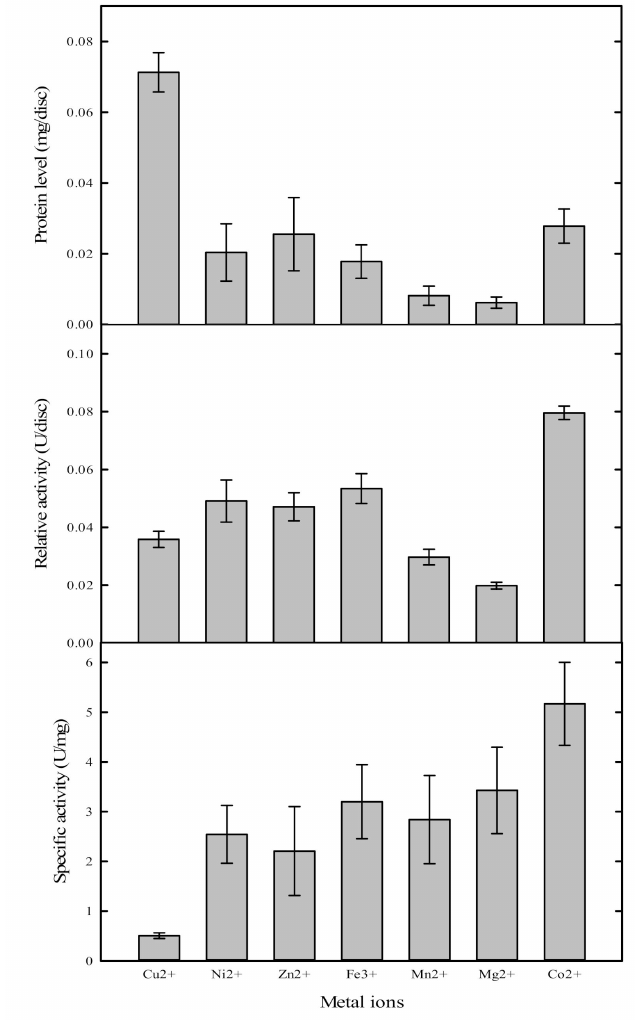
Figure 4. The e ff ects of various metal ions on the ( top ) XynCt adsorption capacity, ( middle ) activity, and ( bottom ) specific activity of the IMAM-ions-CipA-XynCt. The error bars represent SD, n =